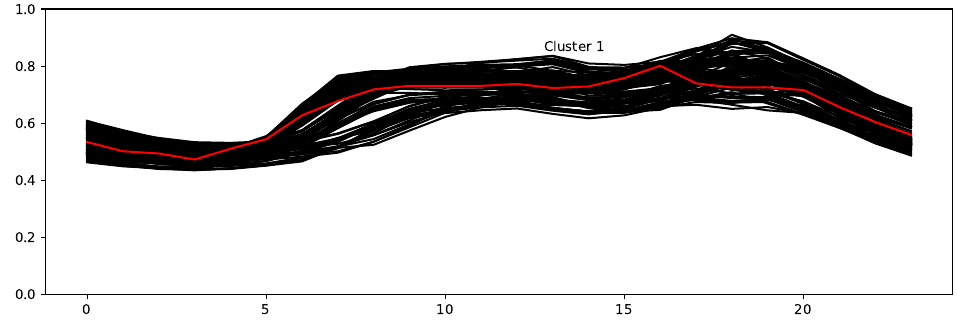
Figure A3. Season 3 demand data